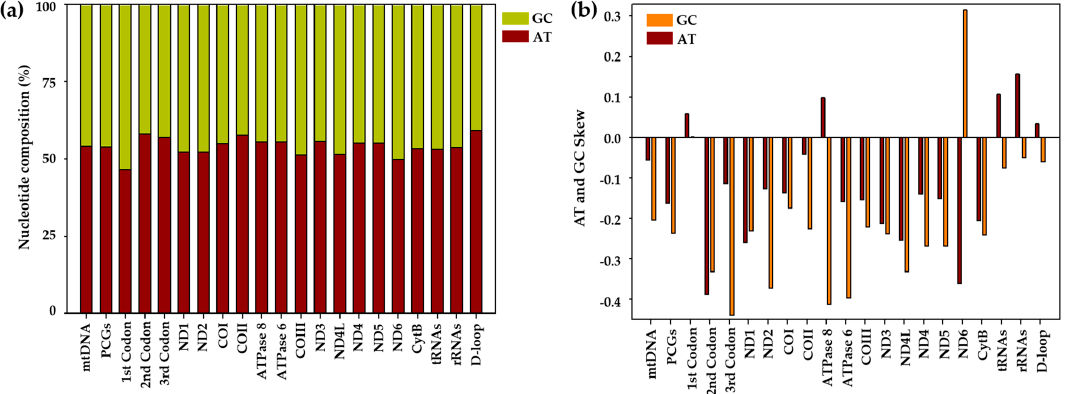
Figure 3. Graphical representation of nucleotide composition contents and AT and GC skew. They should be listed as: ( a ) nucleotide composition AT% and GC%; ( b ) AT and GC skew. Table 2. Gene annotations of the complete mitochondrial genome of C. wui The mitogenome of C. wui is 54.0% AT-biased, with 25.5% A, 28.5% T, 18.3% G, and 27.7% C, which is also